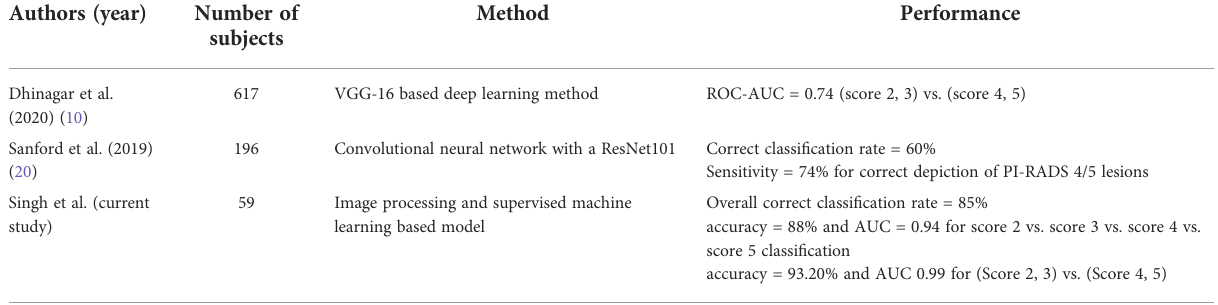
TABLE 3 A comparison of the current study ’ s performance with the recent related